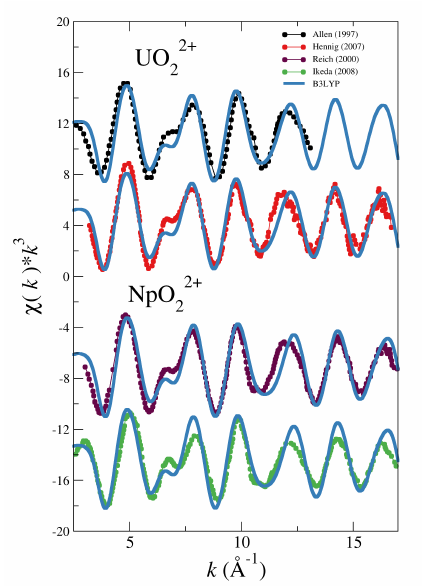
Figure 2. Simulated (blue solid line) and experimental (dots) L III -edge k 3 -weighted EXAFS spectra for UO 2+ and NpO 2+ in water. The experimental EXAFS are taken from Allen (1997) [5] (black dotted 2 2 line) and Henning (2007) [30] (red dotted line) for uranyl, and from Reich (2000) [31] (magenta dotted line) and Ikeda (2008) [32] (green dotted line).